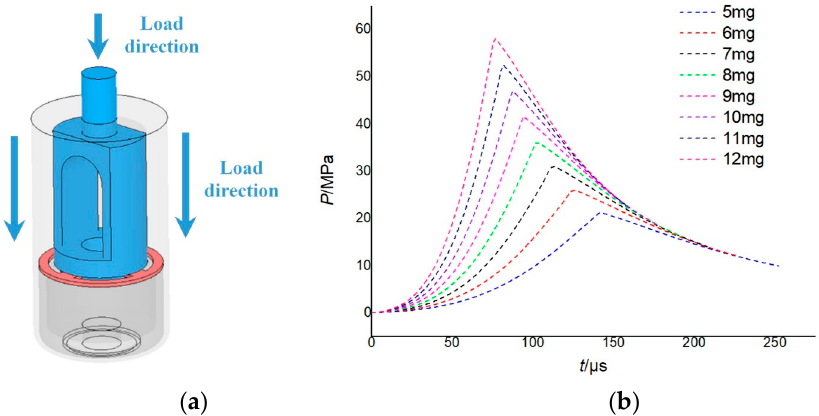
Figure 9. Typical conditions: ( a ) load direction, ( b ) pressure–time curve used in simulations.